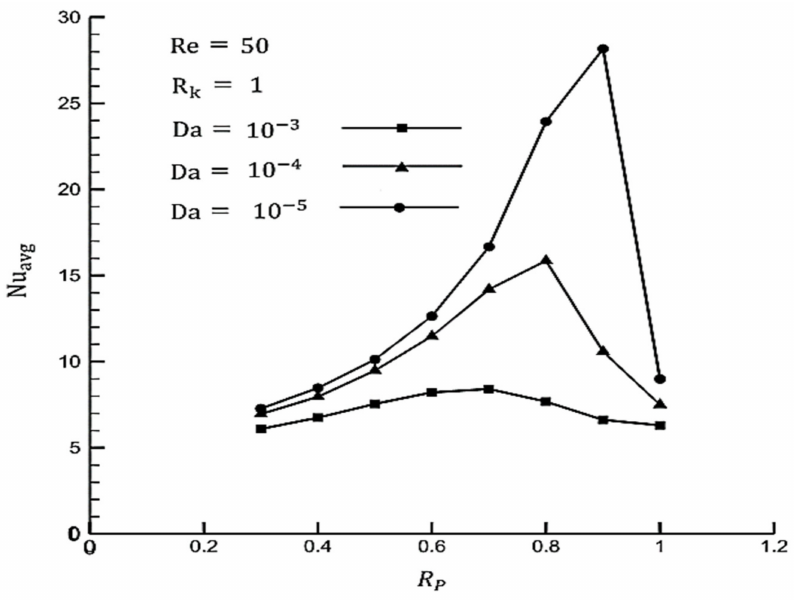
Figure 15. Average Nusselt for variable porous thickness in concentric